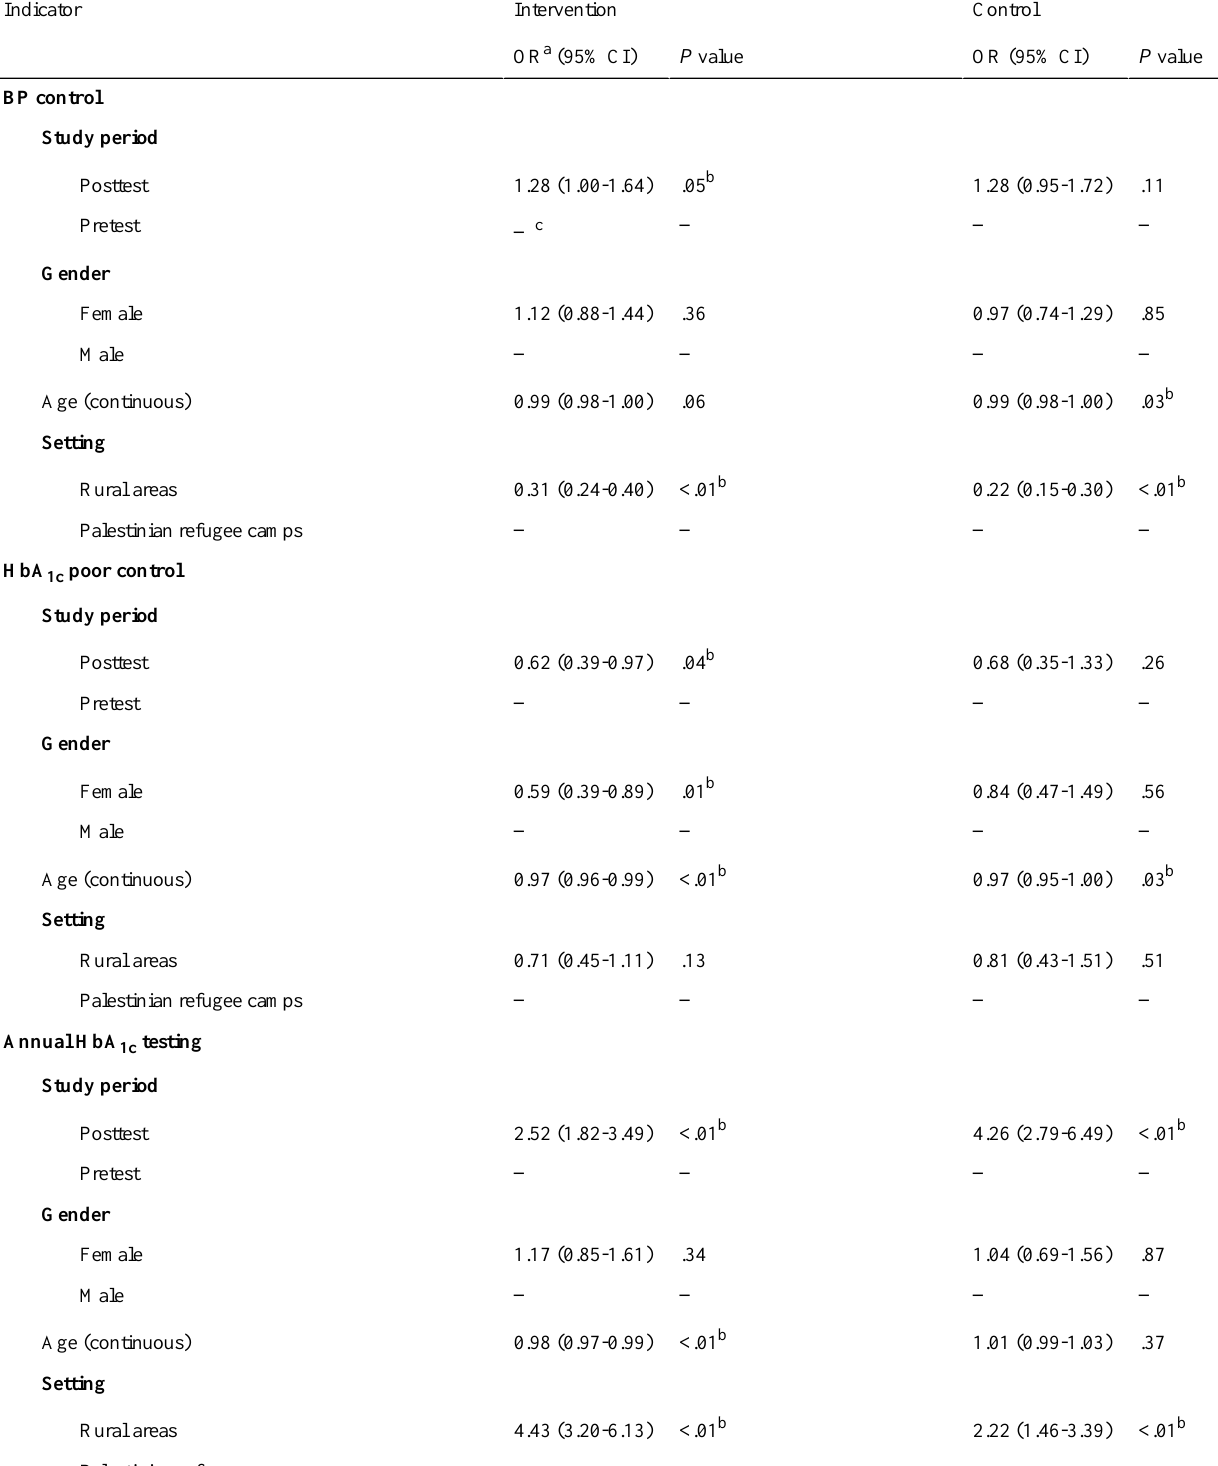
Table 4. Logistic regression model of blood pressure (BP) control, glycated hemoglobin (HbA 1c ) poor control, and annual HbA 1c testing by study